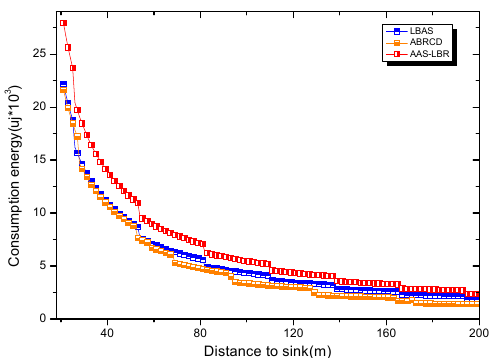
Figure 29. Energy consumption of nodes 20–200 m away from sink under 𝑇 = 60 and r = 28 m .